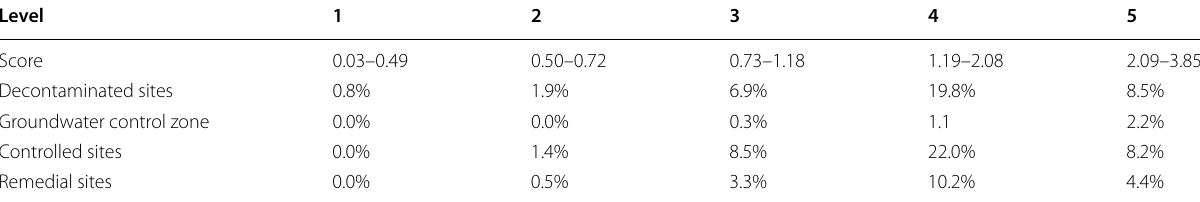
Table 5 The proportions of contaminated factories in SDGs map levels